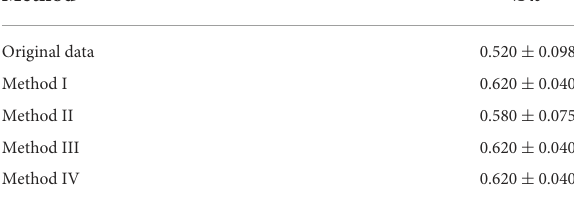
TABLE 3 Average kappa value of the individual methods.